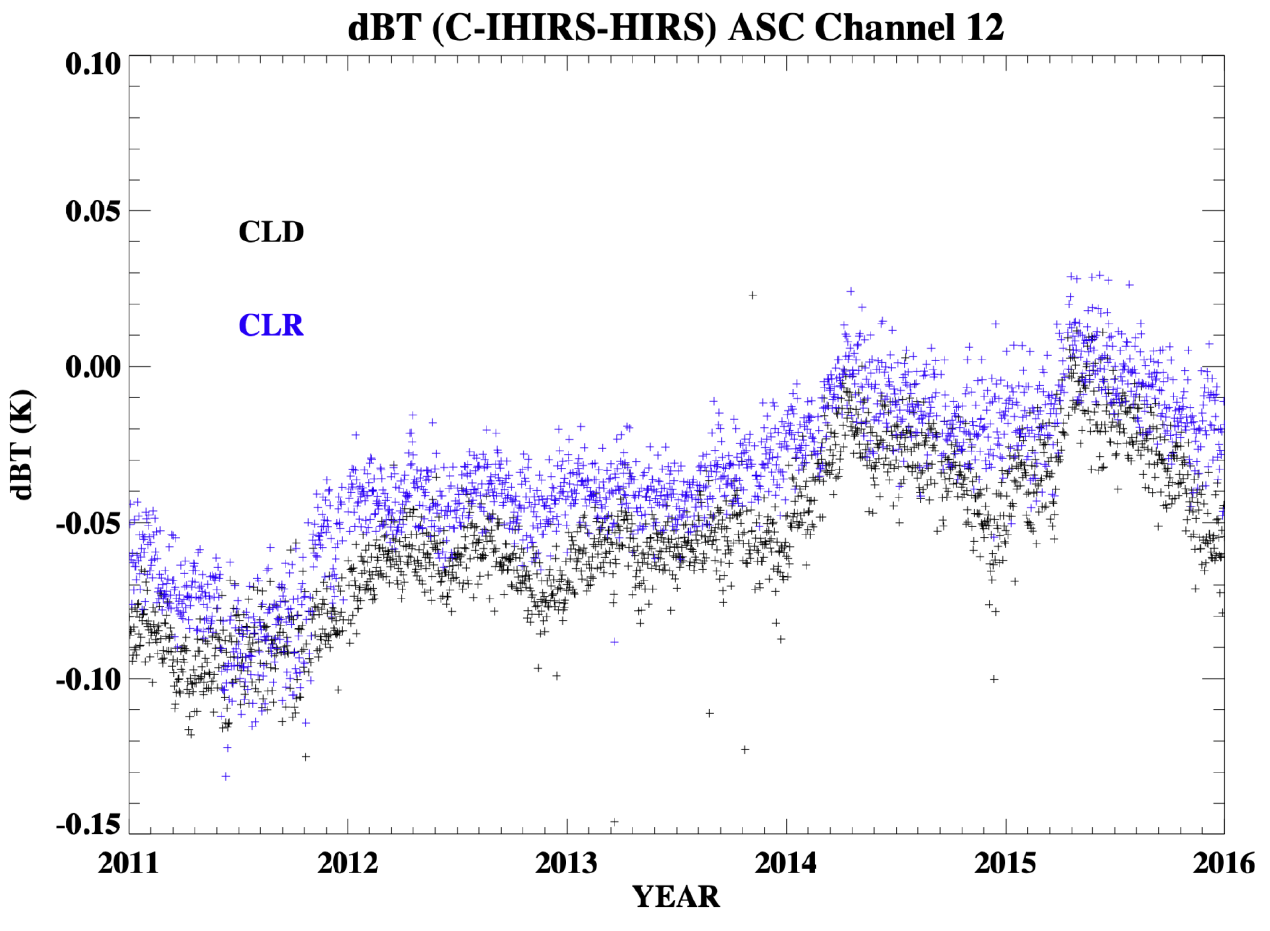
Figure 10. Same as Figure 9 except for channel 12.